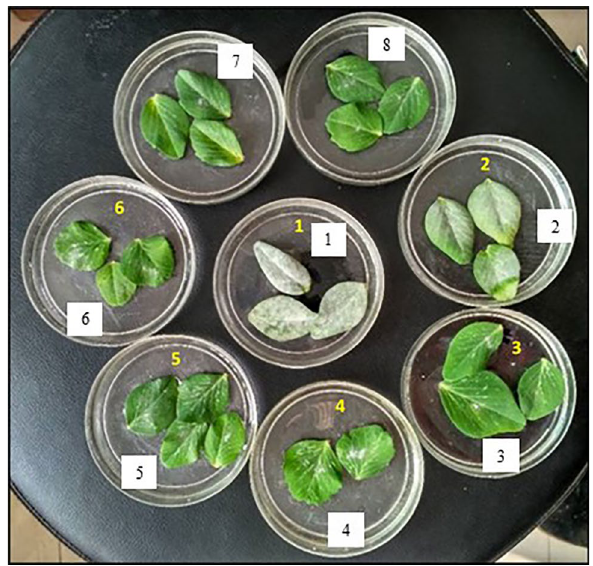
Figure 2. Detached leaf assay with disease reaction of identified desirable genotypes: 1: Lincoln (S), 2: Azad-P1 (S), 3: Pb-89 (MS), 4: SP-6 (MR), 5: SP-22 (MR), 6: SP-3 (MR), 7: Palam Sumool (R), 8: SP-7 (R) where S is susceptible, MS is moderately susceptible , MR moderately resistant, R is resistant.